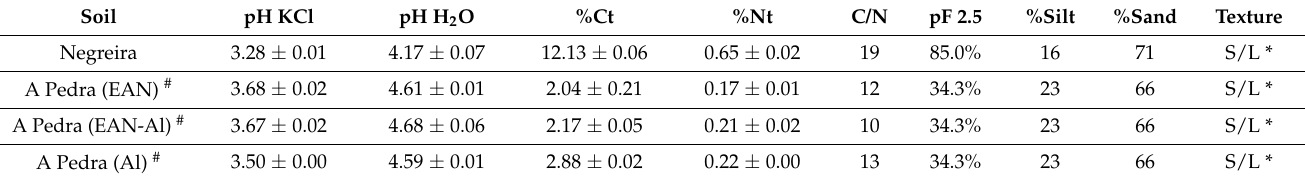
Table 2. The main physico-chemical properties of the soils used in the study. Mean values ± stand- ard deviations.